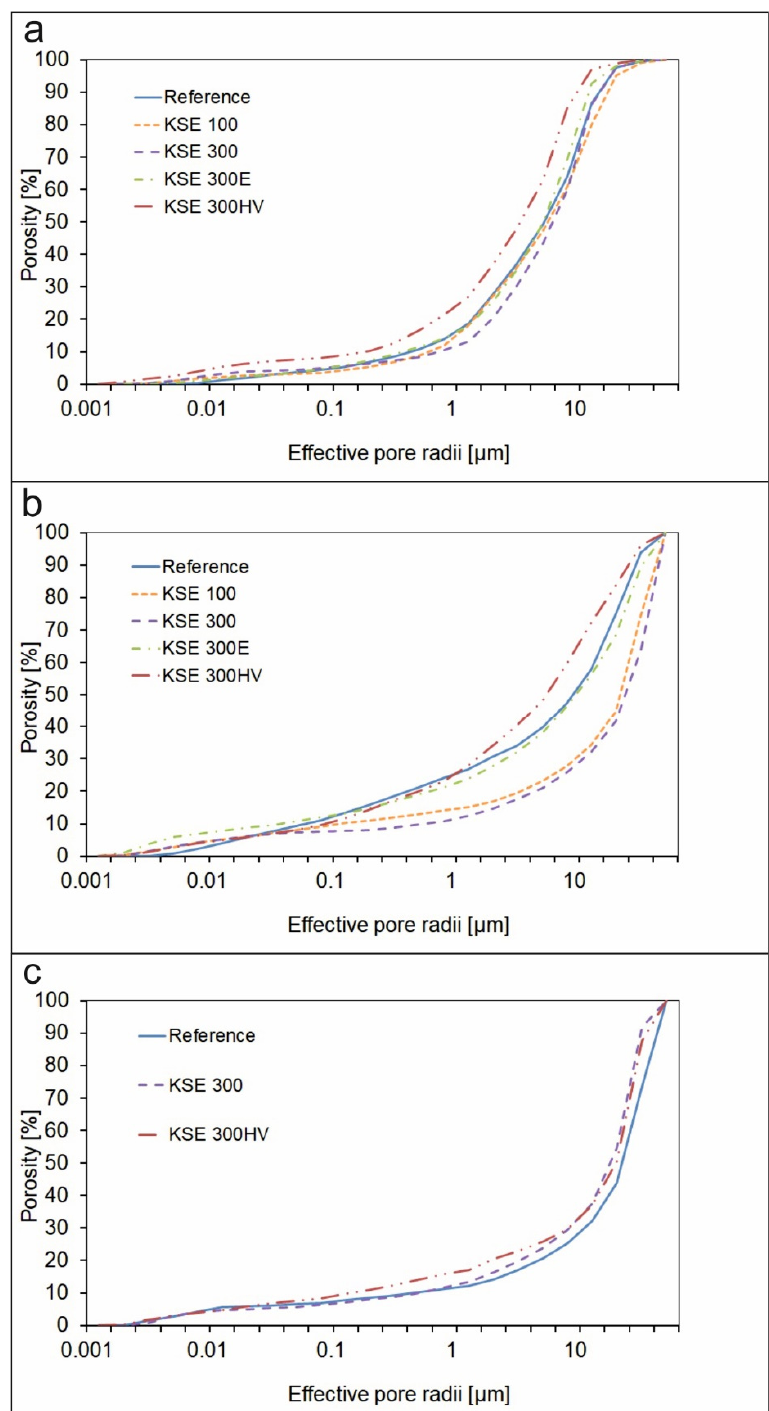
Figure 7. Pore size distribution in untreated samples and change of pore size distribution due to consolidation: ( a ) SF; ( b ) SM; ( c ) FR.